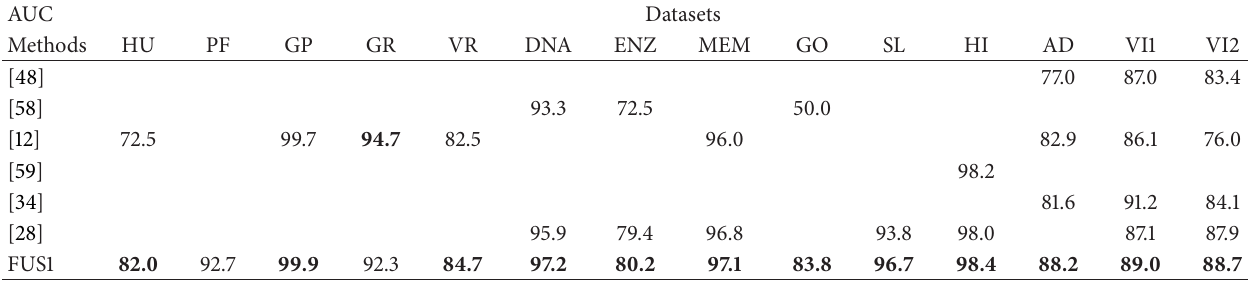
Table 9: Comparison with the state-of-the-art using AUC as performance indicator. AUC